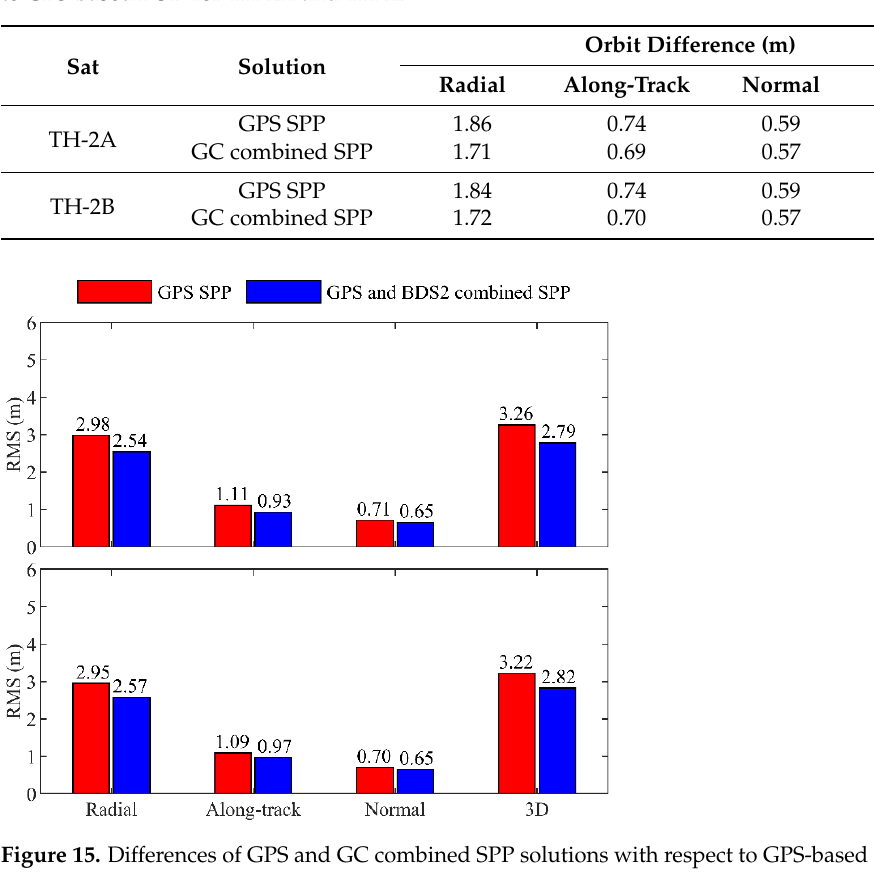
Table 5. Average RMS of orbit differences of GPS-only and GC combined SPP solutions with respect to GPS-based POD for TH-2A and TH-2B.